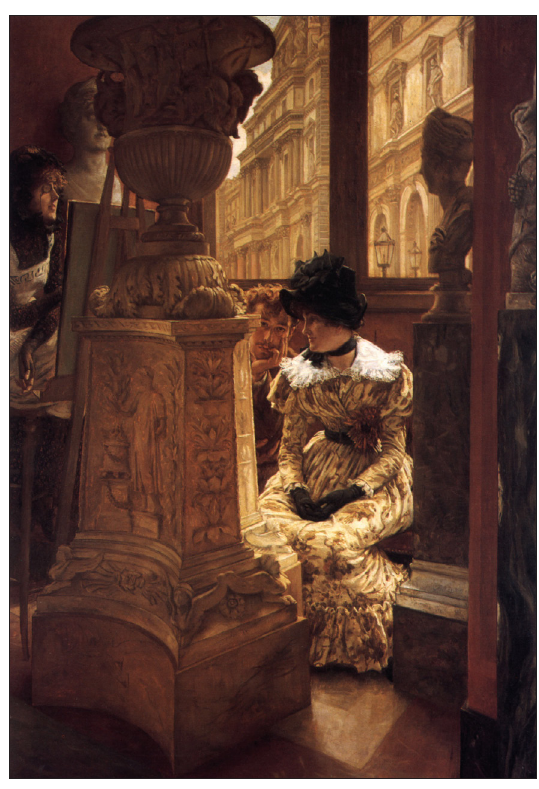
Fig. 2 : James Tissot, Au Louvre (L’Esthétique) , 1883, oil on canvas, 100 × 144 cm, Museo de Arte de Ponce. Wikimedia